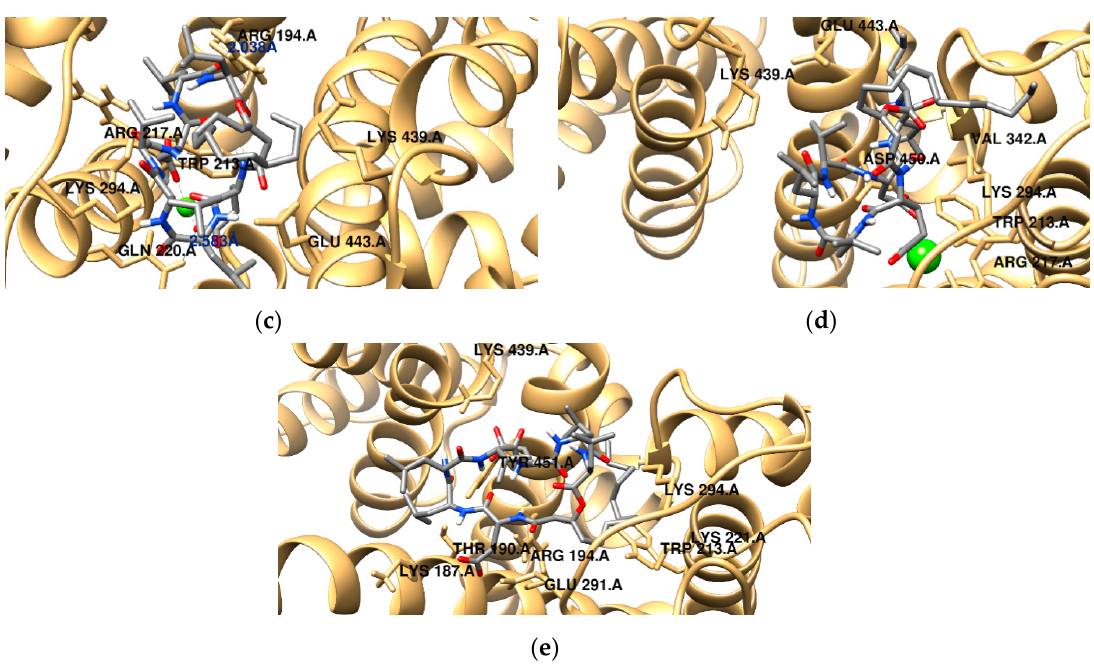
Figure 7. Predicted binding modes of surfactin and its metal complexes with BSA using molecular docking simulations. Cu 2+ -surfactin/BSA ( a ), Zn 2+ -surfactin/BSA ( b ), Mg 2+ -surfactin/BSA ( c ), Ca 2+ - surfactin/BSA ( d ), and surfactin/BSA ( e ).